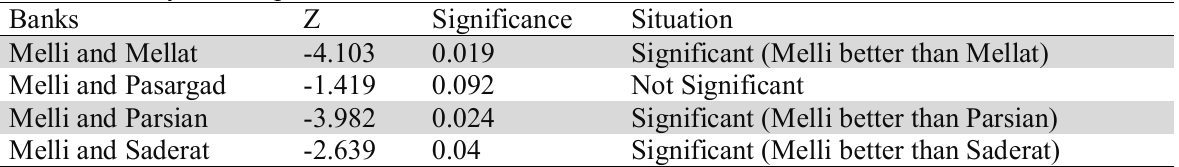
Mann-Whitney test for